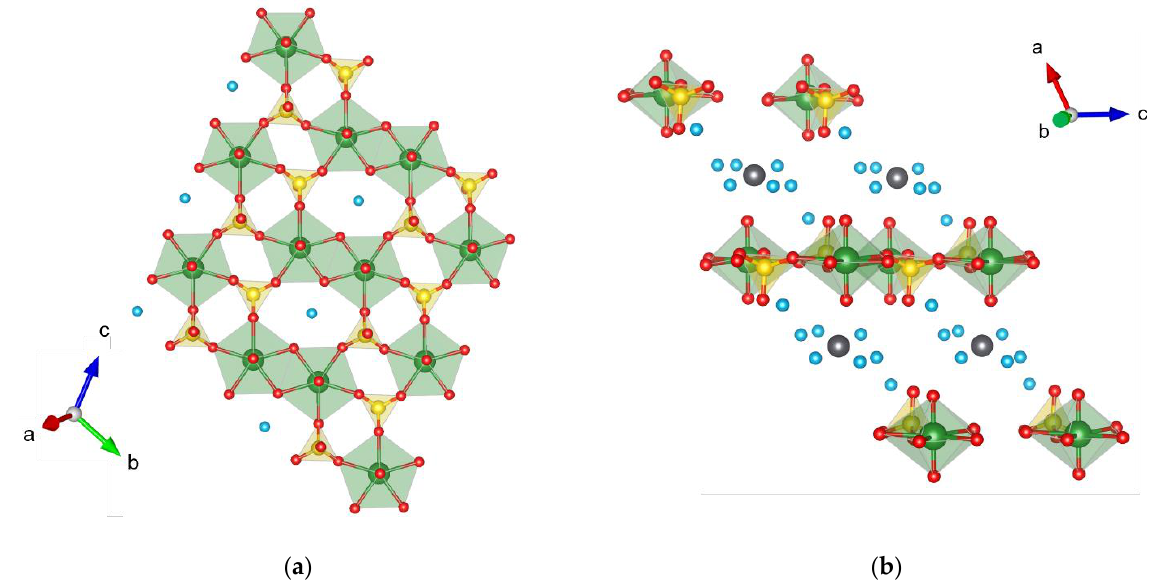
Figure 1. Johannite crystal structure images of: ( a ) the uranyl sulphate sheet; and ( b ) sheet-interlayer stacking. Atoms of U, O, S, and Cu are coloured green, red, yellow, and grey, respectively, with water molecules shown in light blue. The images were created using VESTA-3 software [25] based on the X-ray diffraction analysis by Mereiter [24].